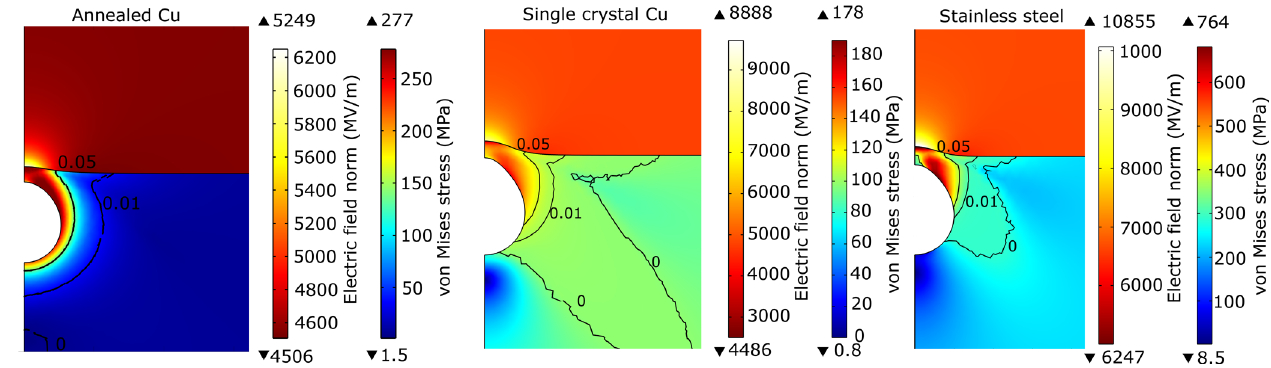
FIG. 3. Snapshots of the von Mises stress and electric field distributions during the elastoplastic deformation of simulated materials. The aspect ratio of the position of voids in all cases is 0.5. The contours represent effective plastic strain 0, 0.01 and 0.05 values.